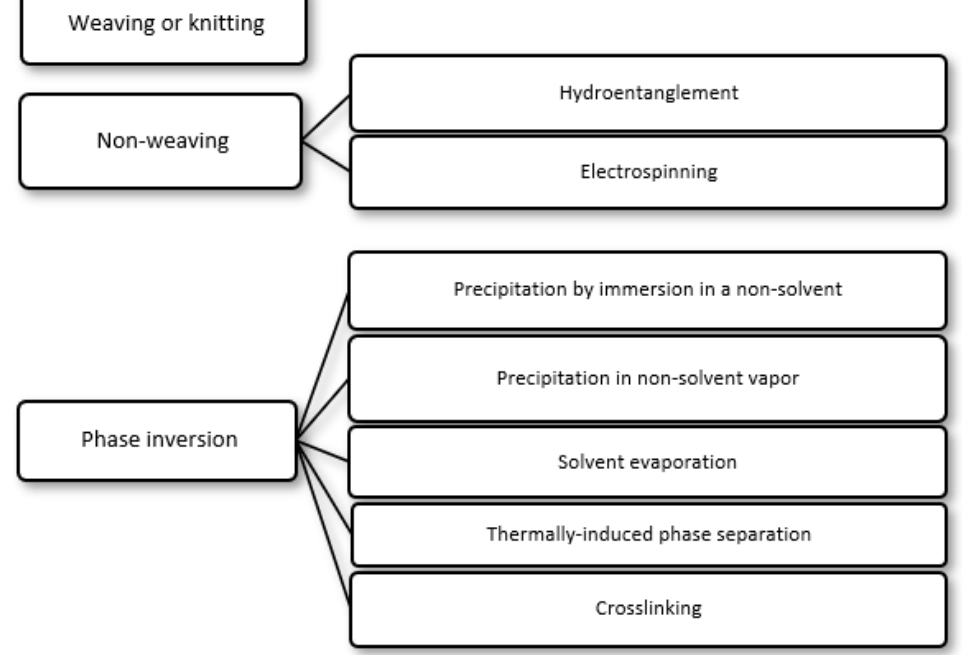
Figure 1. Methods commonly employed in the preparation of membranes for wound